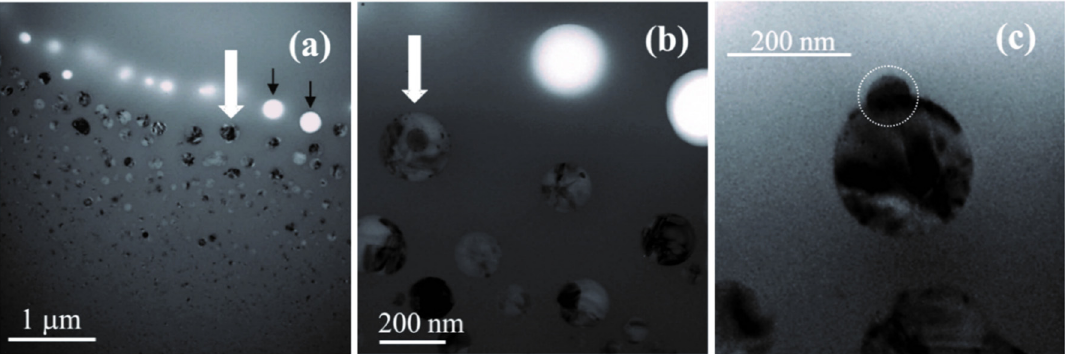
Figure 13. TEM images of a 0.5- μ m-thick Si/SiO 2 SL showing a Si particle located near the film surface (marked with a white arrow). The images in ( a ), ( b ), and ( c ) are taken with different magnification. ( c ) shows this particle in the tilt geometry, the surface subparticle being indicated by a dotted circle. The bright spots are holes in the film; the holes observed in ( b ) are marked by black arrows in ( a ). Figure courtesy of Simona Boninelli and Fabio Iacona. Reproduced with permission from [141]. Copyright 2012, AIP Publishing